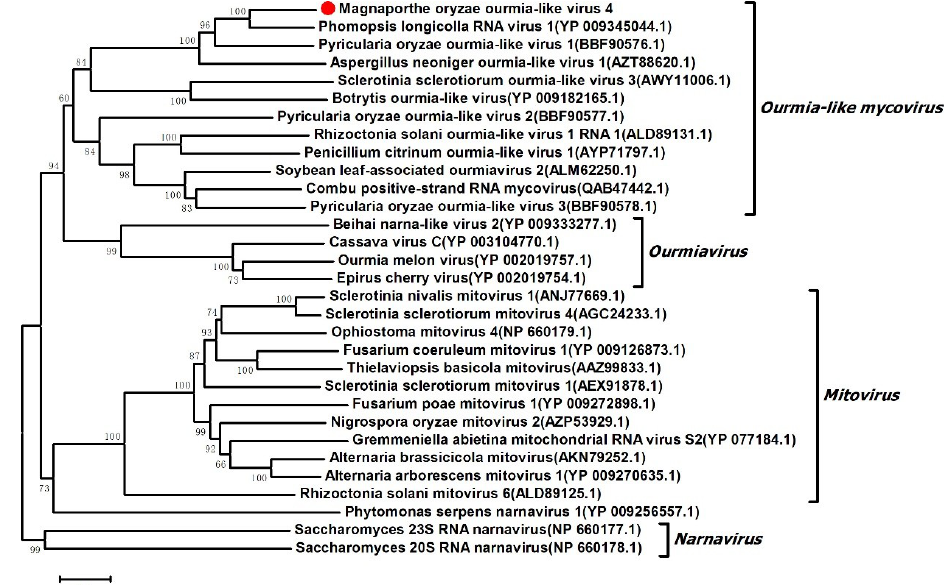
Figure 4. Phylogenetic analysis of MOLV4. The phylogenetic tree was constructed based on the alignment of aa sequences of RdRp using the neighbor-joining method. The bootstrap values were calculated with 1000 replicates. Bootstrap values are shown next to the branches. MOLV4 is indicated red dot in the phylogenetic tree and the substitutions per nucleotide position are represented by scale bars.